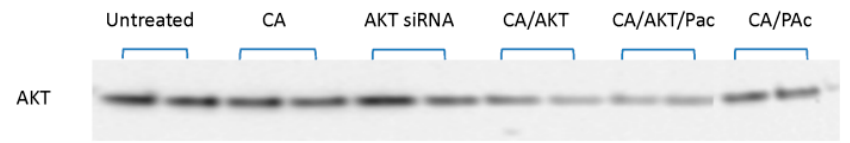
Figure 3. AKT protein expression in MCF-7 cells. Cells were treated with media (untreated), carbonate apatite, free AKT siRNA, CA/AKT siRNA, CA/AKT/Pac, and CA/Pac. Ingredients include 3 mM of CaCl 2 , 1 nM siRNA, and 1 nM Pac. Cellular lysates were run in SDS-PAGE and transferred into PVDF membrane and incubated with primary antibodies raised in rabbit against AKT. HRP-conjugated goat anti-rabbit secondary antibody was used to detect the chemiluminescent signals. CA/AKT/Doc in the downregulation of AKT protein against CA/AKT or CA/Doc (Figure 4).